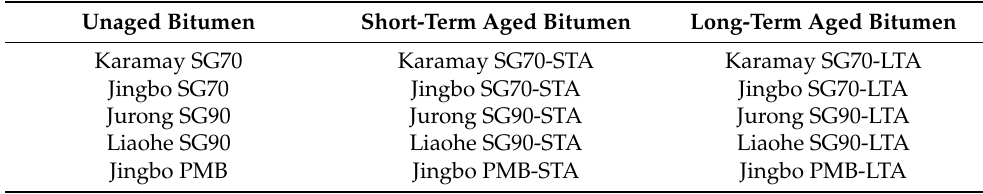
Table 1. Summary of the unaged, short-term aged, and long-term aged bitumen binders. Unaged Bitumen Short-Term Aged